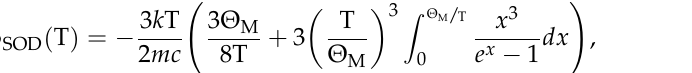
Figure 4. Mössbauer spectrum of human liver ferritin (200 mg) measured in 4096 channels at 295 K. Components 1–4 are the result of the best fit with free variation of parameters. The differential spectrum is shown on the bottom. Adapted from Ref. [39] with permission from Springer Nature: Hyperfine Interactions, Mössbauer spectroscopy with high velocity resolution in the study of ferritin and Imferon: preliminary results, Oshtrakh M.I., Milder O.B., Semionkin V.A., ©2008.